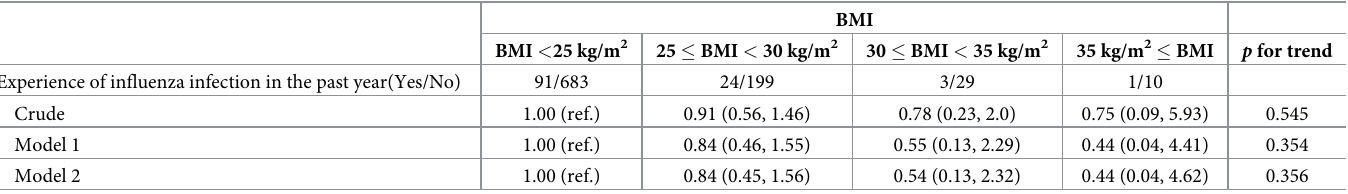
Values are adjusted odds ratios (95% confidence intervals). Logistic regression analyses were performed. Model 1 was adjusted for age, sex, and VFA. Model 2